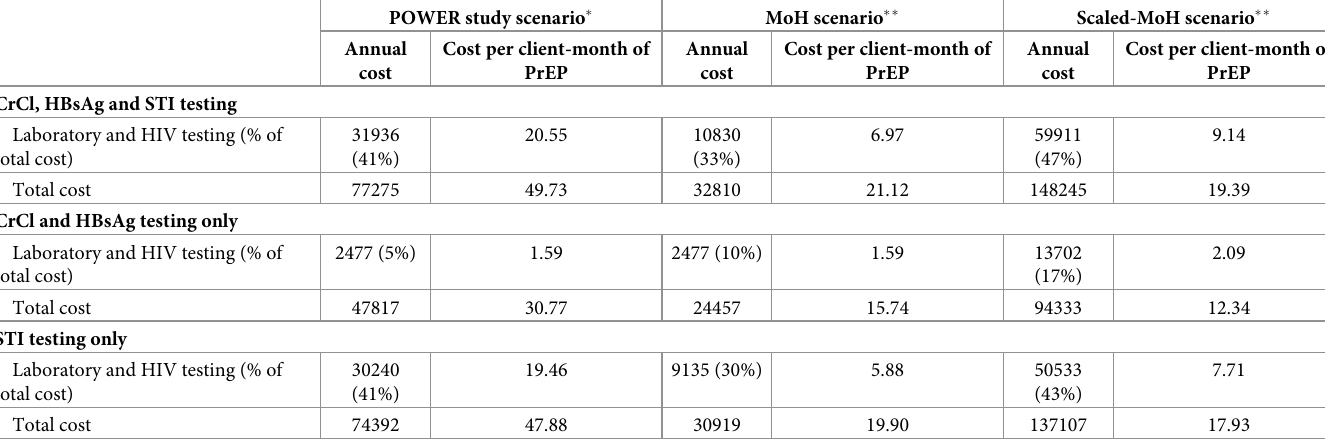
Table 4. Economic costs by laboratory testing at initiation visit (2019